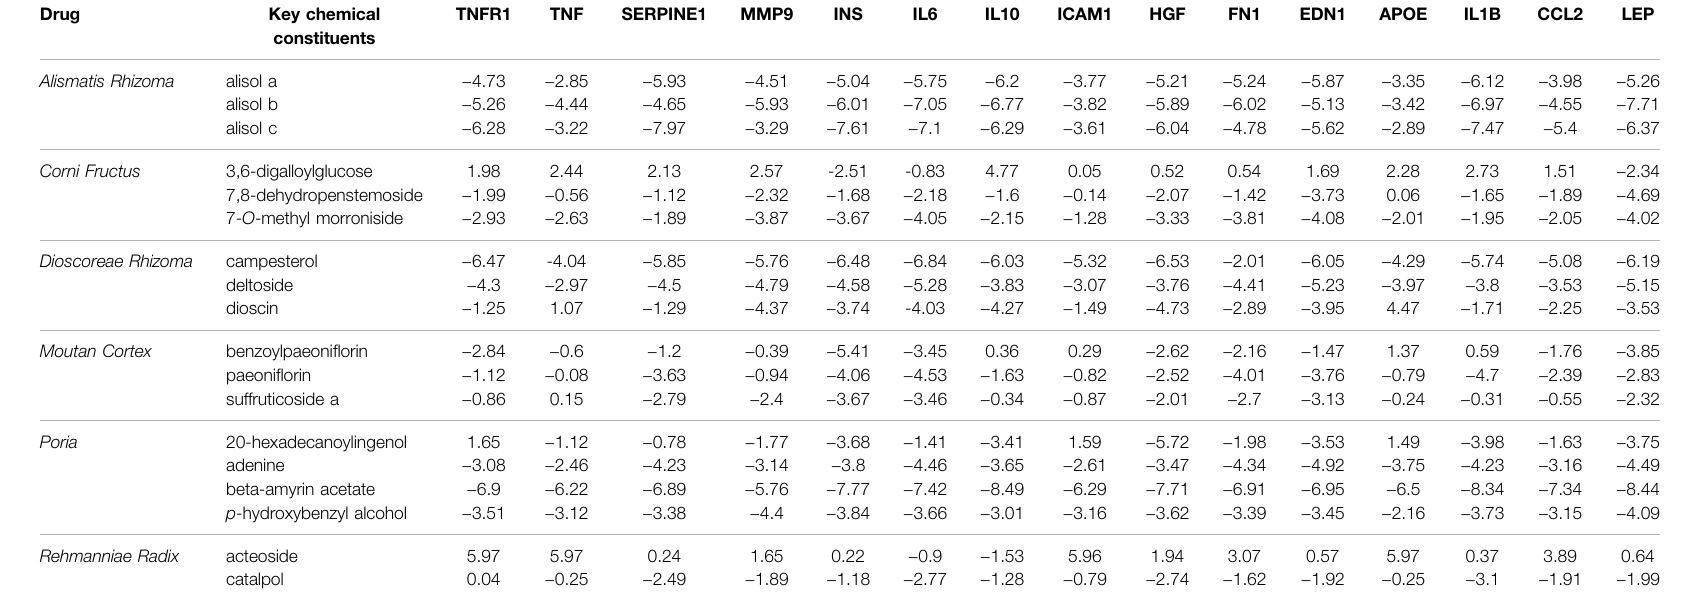
TABLE 3 | Binding af fi nity of key chemical compounds of R-6 to putative targets. Drug Key chemical constituents Alismatis Rhizoma